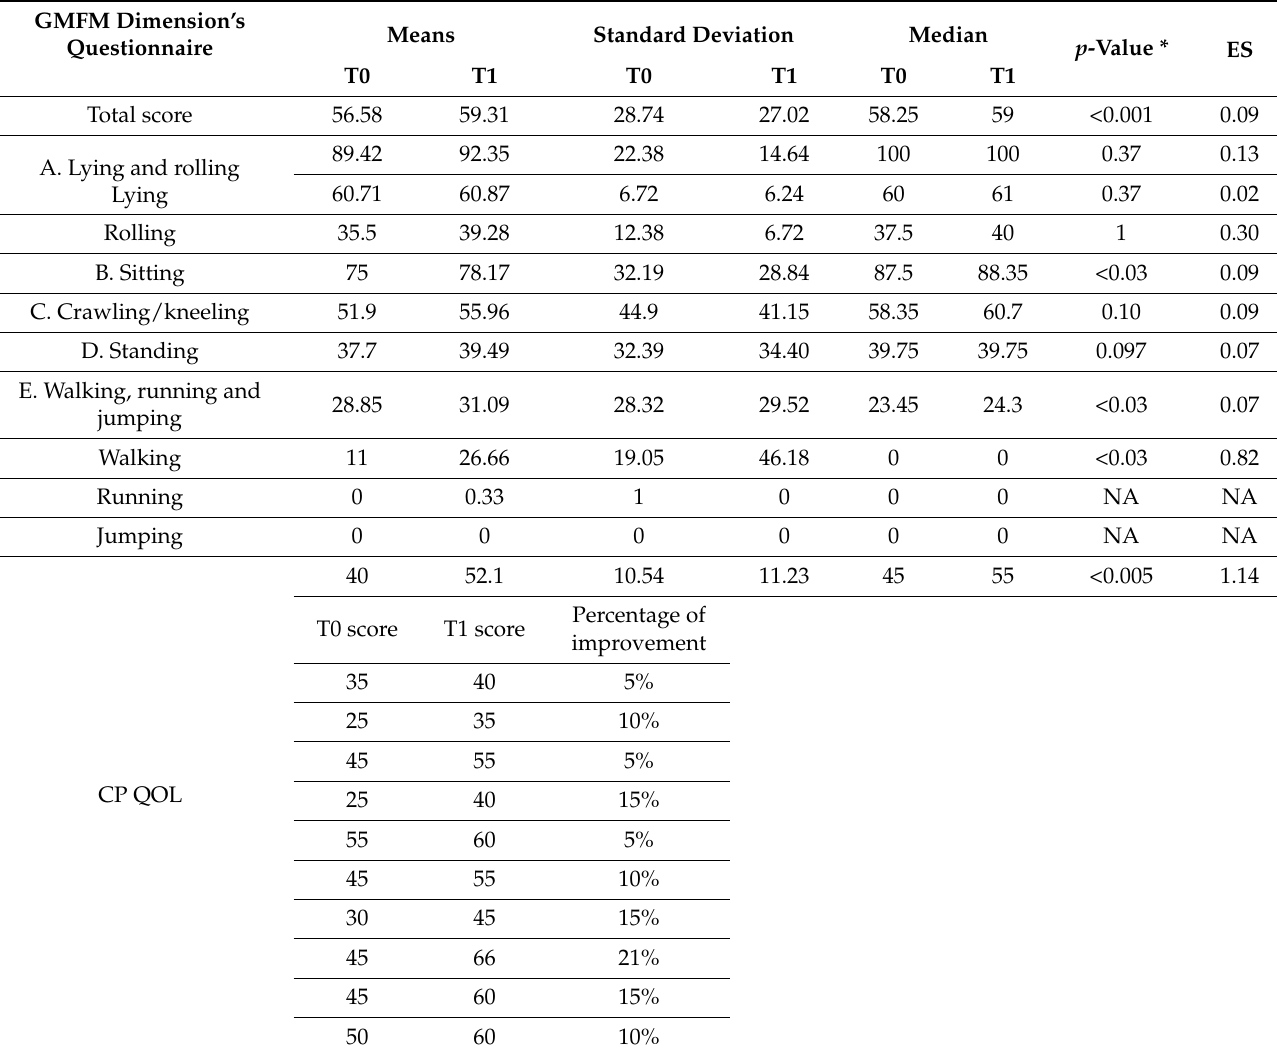
Table 1. Statistical analysis of Gross Motor Function Measure and Cerebral Palsy Quality of Life ASCP’s